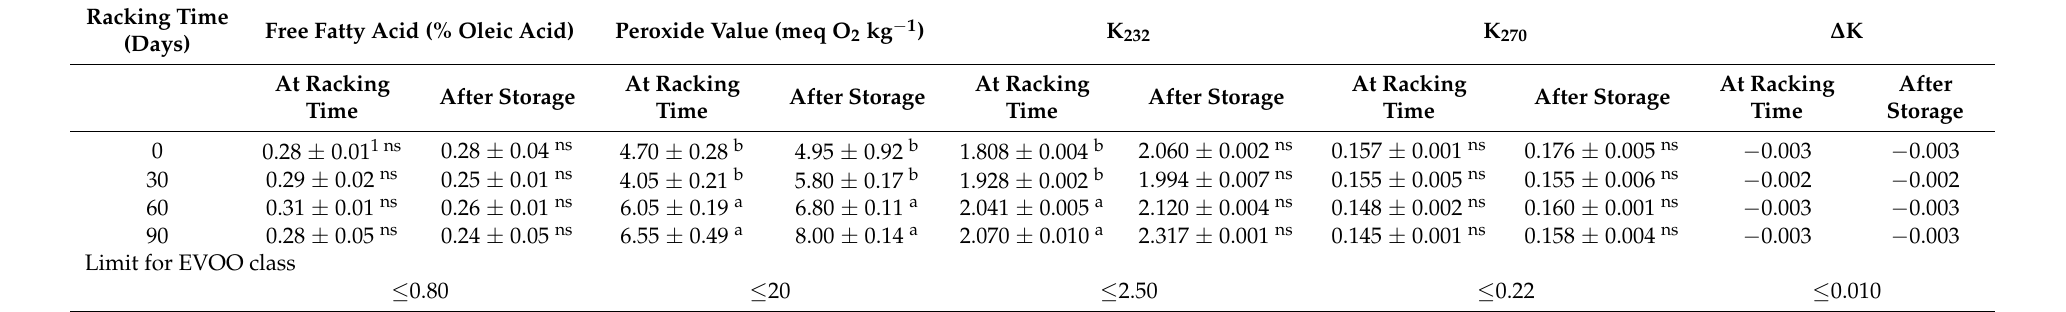
Table 8. Analytical indices of Coratina monocultivar EVOO evaluated at racking time and at the end of